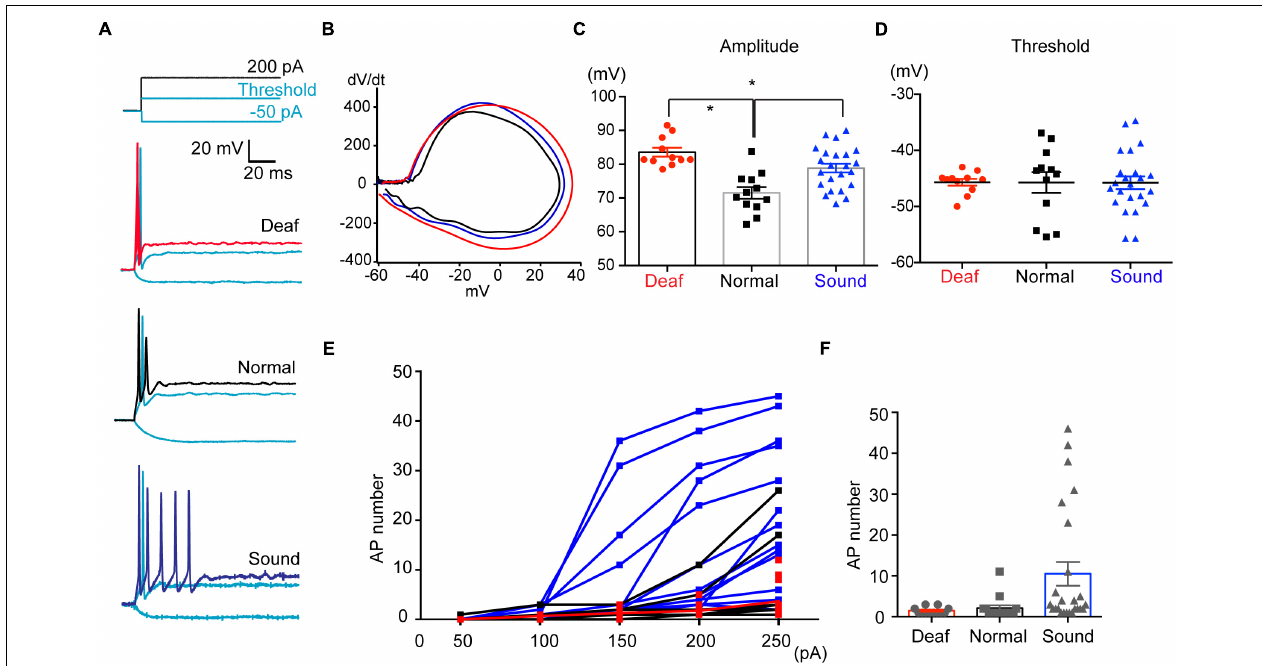
FIGURE 7 | Sound stimulation increases the excitability of HF neurons in the MNTB. (A) Representative traces of APs evoked by step-like current injections (-50 pA, threshold current, 200 pA) from Deaf, Normal, and Sound groups (P17- P20). (B) Representative plot of dV/dt of AP against membrane potential in Deaf (red), Normal, and Sound. (C,D) Summary of the amplitude and threshold of APs, evoked by 200 PA current injection, from Deaf, Normal, and Sound groups. ∗ p < 0.05, one-way ANOVA with Turkey’s multiple comparison test or Kruskal–Wallis test with Dunn’s post hoc test. (E) The plot of spike number evoked by current injections (50 pA to 250 pA, 100 ms) in HF neurons from Deaf, Normal, and Sound groups. (F) Summary of spike number evoked current injection (200 pA). ∗ p < 0.05, Kruskal–Wallis with Dunn’s post hoc test.